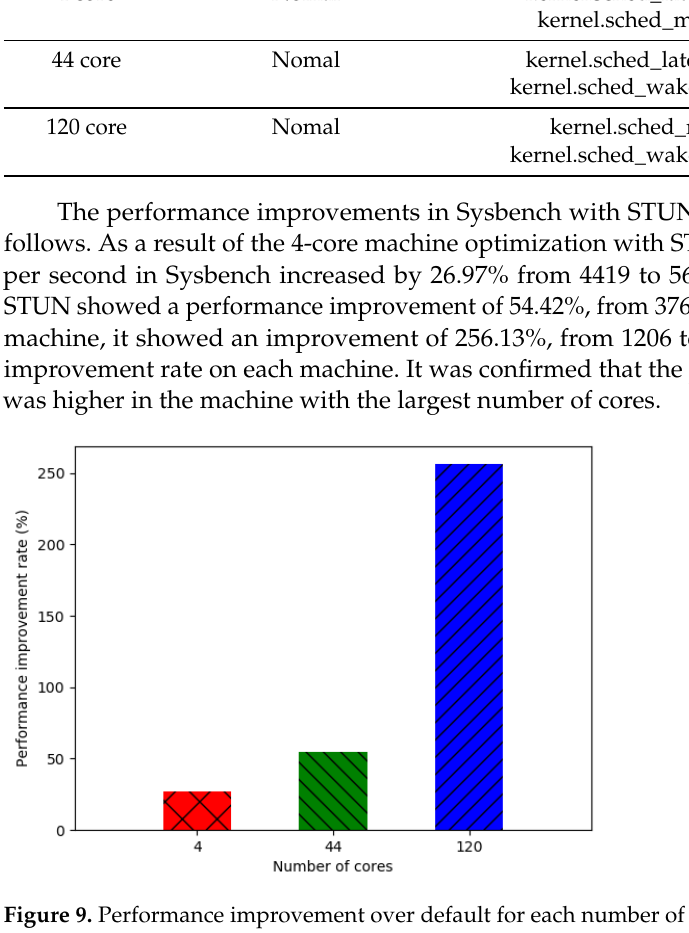
Figure 9. Performance improvement over default for each number of